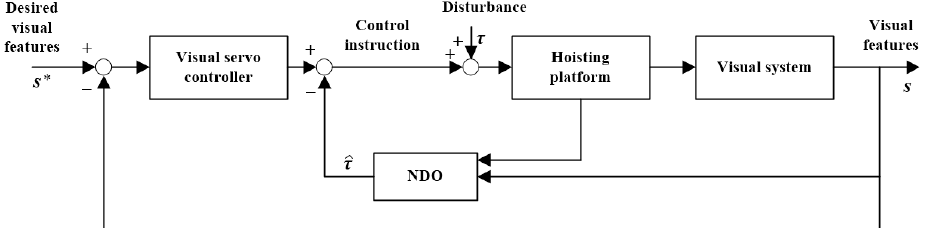
Figure 6. The visual servo structure of adaptive control with Nonlinear Disturbance Observer (NDO) for hoisting positioning.